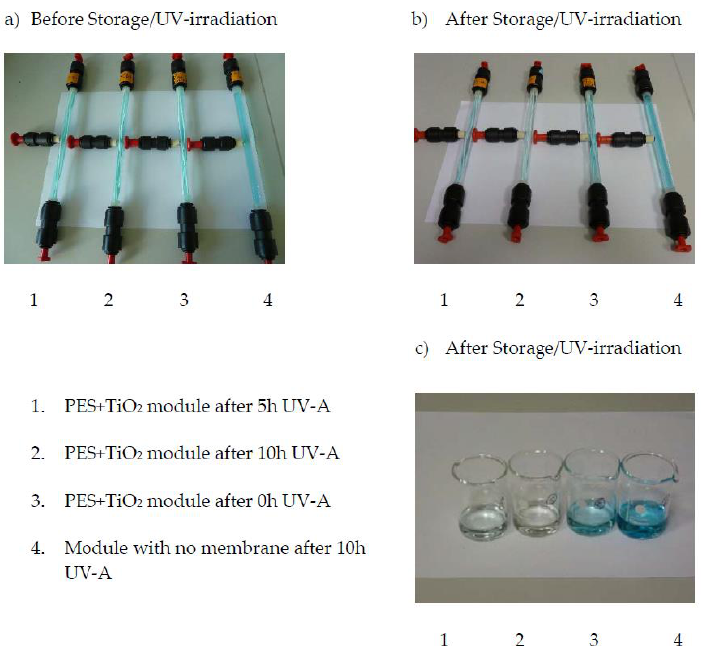
Figure 9. Qualitative concentration change of the aqueous methylene blue solution: ( a ) Images of modules before storage or UV-A irradiation; ( b ) Images of modules after storage or UV-A irradiation; ( c ) Image of the solutions drained from these modules after storage or UV-A irradiation.